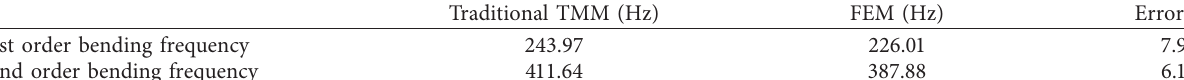
Table 2: The natural frequencies of the stepped shaft.